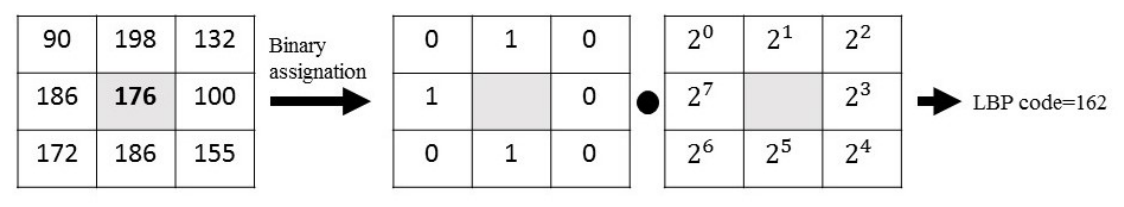
Figure 2. Graphic example of the LBP